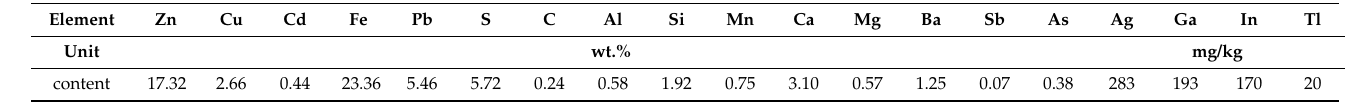
Table 2. Chemical composition of the ZPR sample 1 .